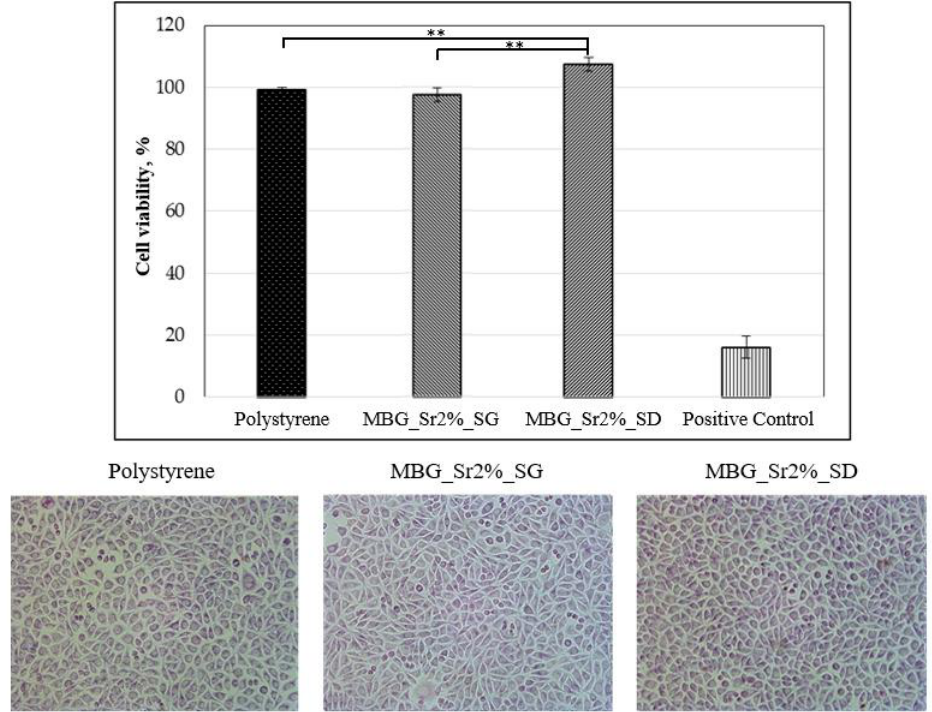
Figure 7. Section above: quantification of cell viability through MTT assay for MBG_Sr2%_ SG and MBG_ Sr2%_SD compared with polystyrene (negative control) and positive control (polystyrene with 0.08 µg/mL of NPS). (** p ≤ 0.01). Section below: optical images of cells after 72 h of incubation with